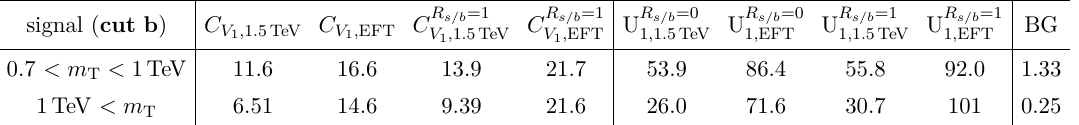
Table 4 . Expected numbers of signal events after cut b (the τ ± ν + b search) for R L dt = 35 . 9 fb − 1 √ s = 13 TeV . See the caption of table 3 for further information. The last column is the expected and number of SM background (see table 2). Detailed cut flows are shown in tables 13 and